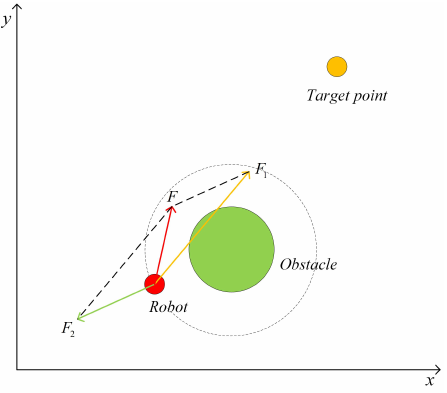
Figure 1. Definition of attractive force and repulsive force in artificial potential